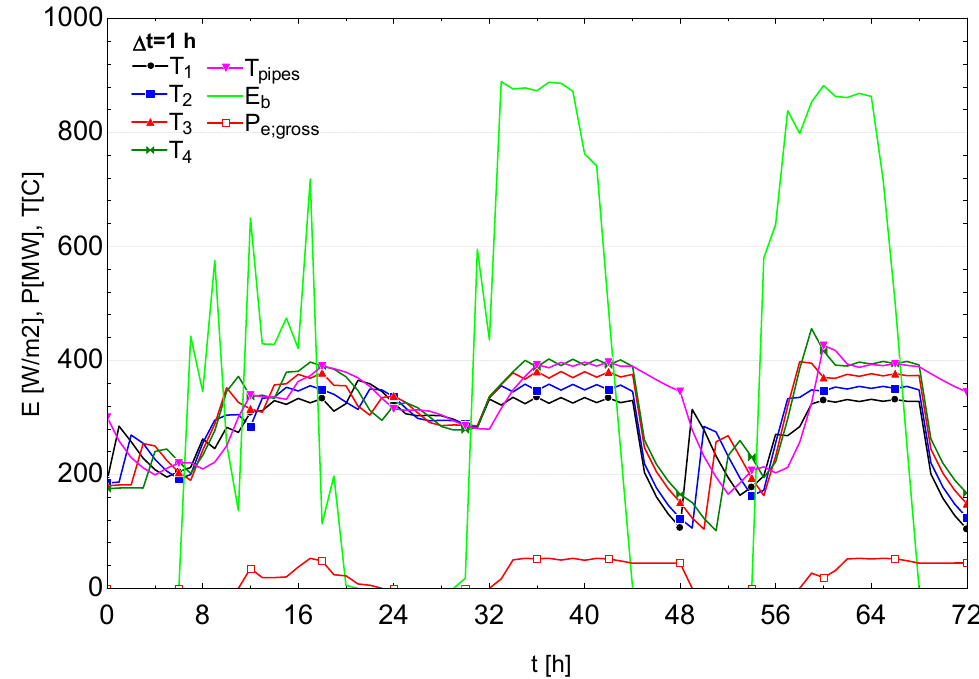
Figure 6. Simulation of direct normal irradiance ( E b ), HTF temperatures in a generic loop ( T i ), and gross electric power ( P e , gross ) for three days in summer, 21–23 June with a time step of 1 h.